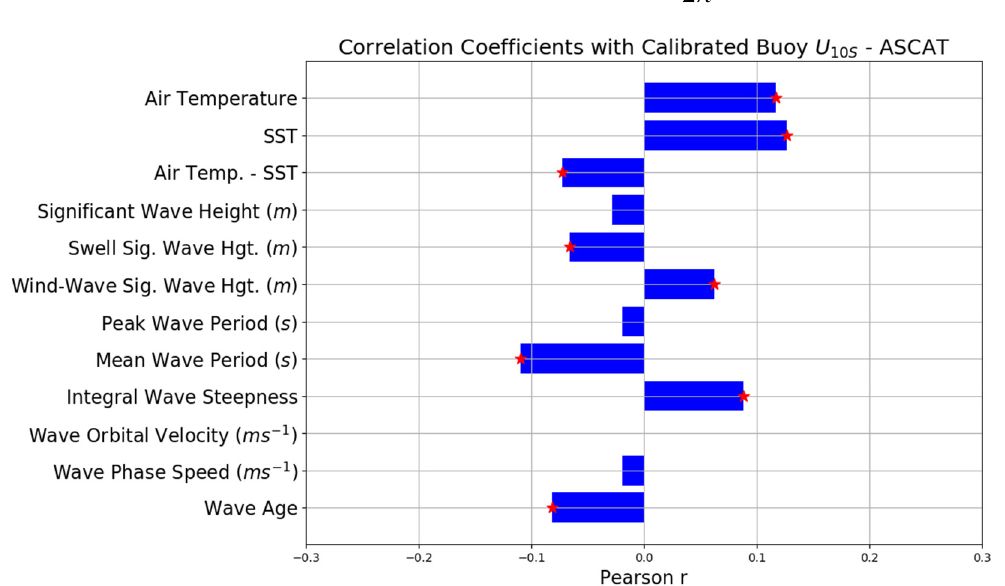
Figure 7. Correlation coefficients of calibrated wind residuals (buoy U 10 S –ASCAT) with sea state parameters. Red stars indicate statistical significance at the 99% level.